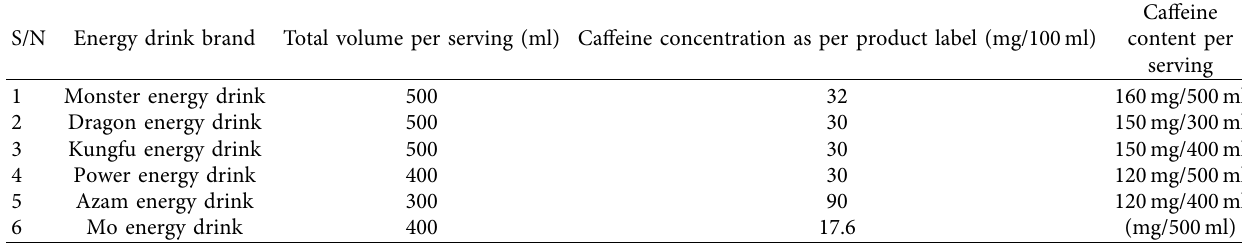
Table 4: Cafeine concentration per serving for various energy drinks according to their package labels. S/N Energy drink brand